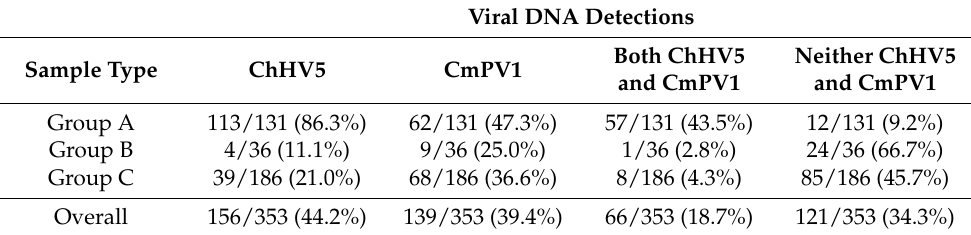
Table 3. The results from the 353 samples screened in this study for the presence of chelonid alpha- herpesvirus 5 (ChHV5) and Chelonia mydas papillomavirus 1 (CmPV1). The results are categorised by sample types: Group A (FP Tumours), Group B (Non-tumoured skin from turtles with FP tumours) and Group C (Skin from non-tumoured turtles). A summary of the total detections is also provided.